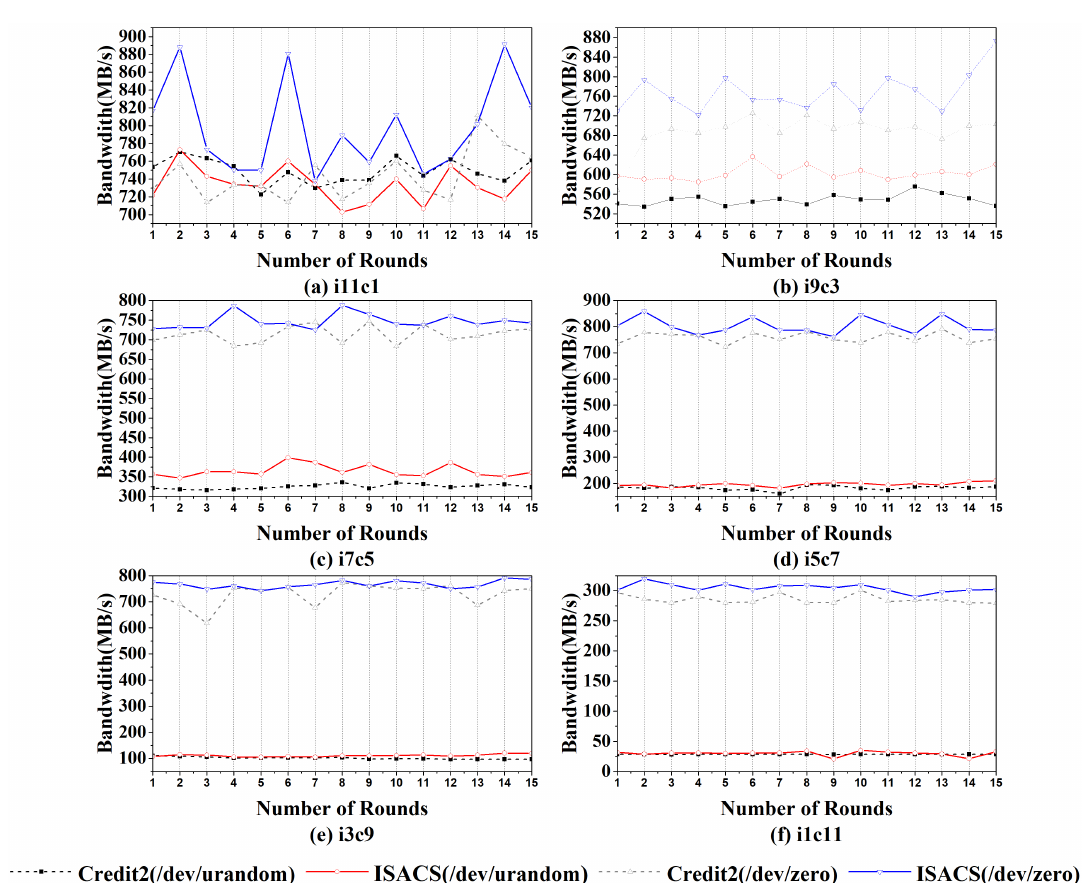
Figure 11. Disk bandwidth in 15 experiments with a different VM configuration in the hybrid